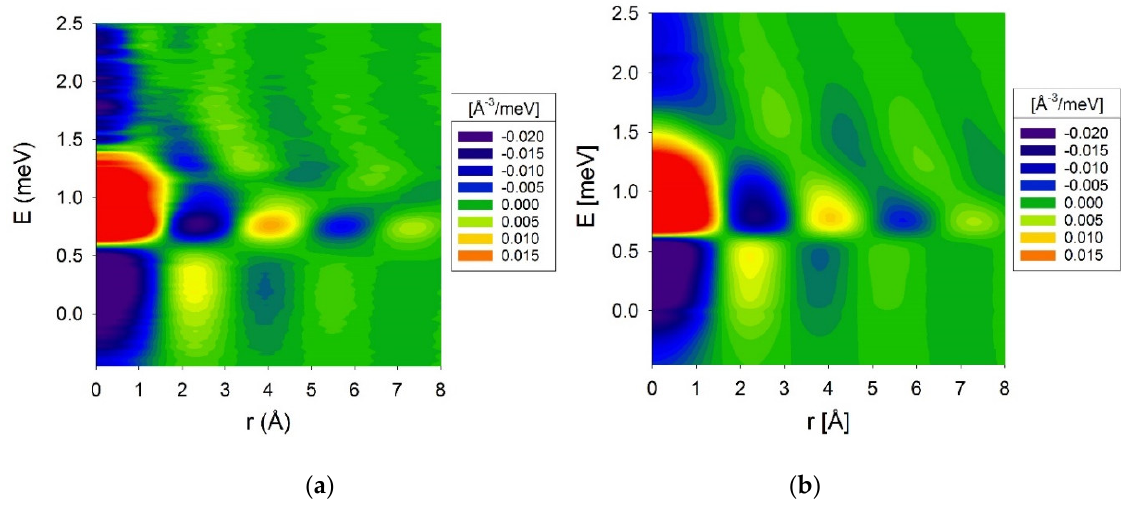
Figure 3. Difference in DyPDF between T = 1.83 K and 2.85 K, ( a ) by inelastic neutron scattering (INS) and ( b ) by quantum Monte-Carlo simulation [29].